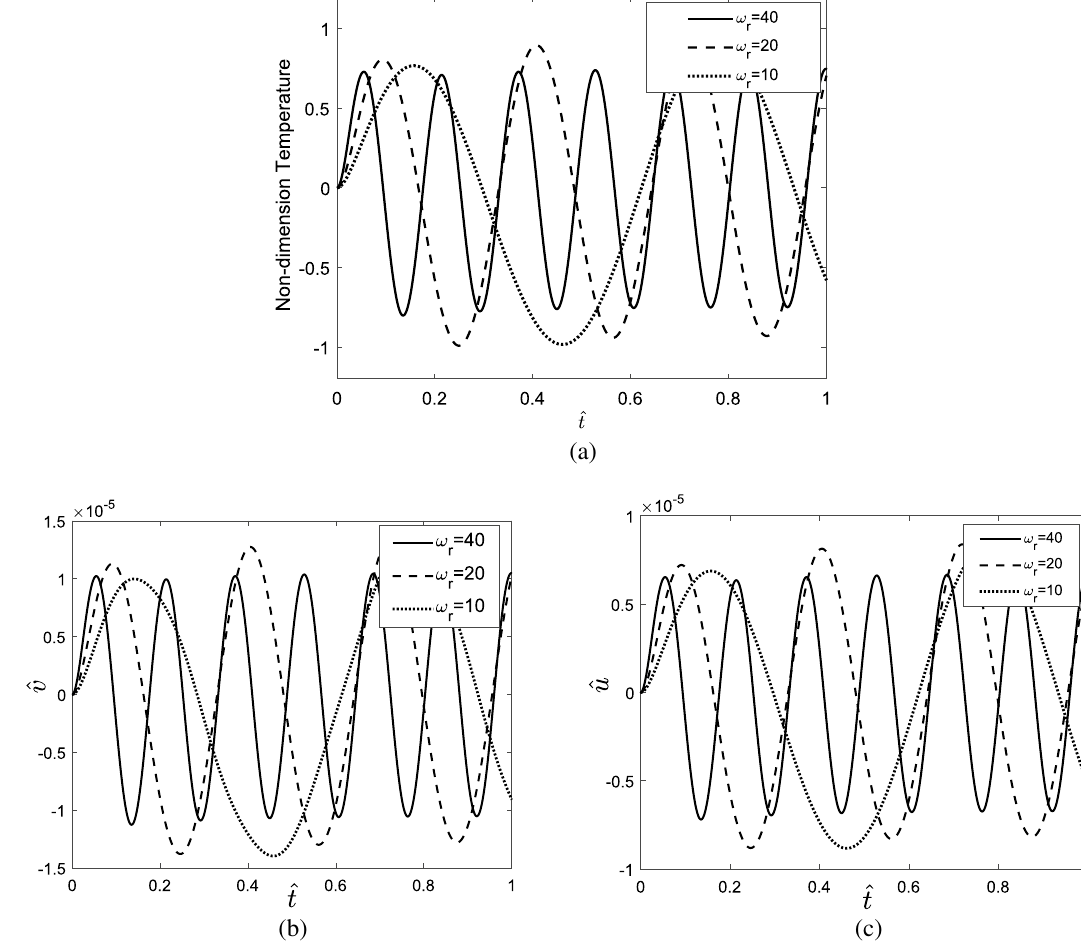
Figure 12. ( a ) Temperature response of the skin tissue, ( b ) displacement of the tissue along radial direction, ( c ) displacement of the tissue along the depth direction, to different frequency ratios.